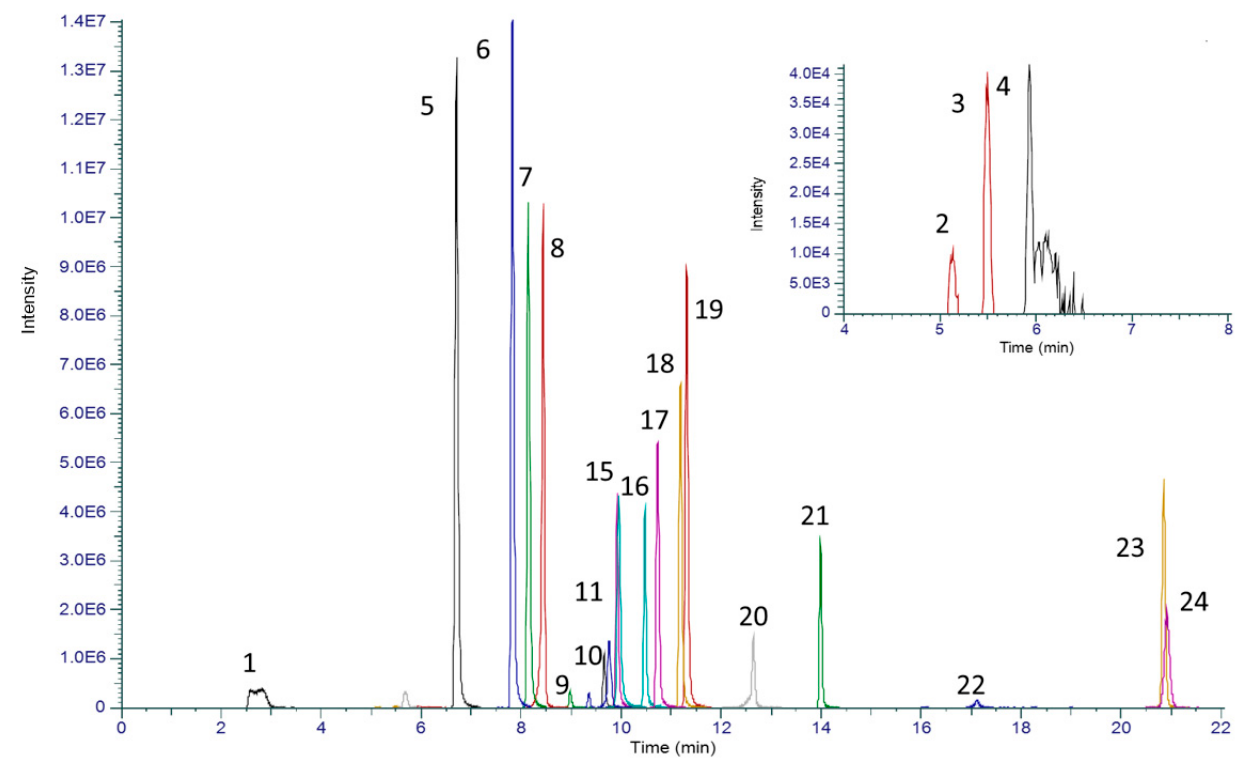
Figure 2. LC-MS chromatogram obtained for the standards (5 µg L − 1 ): 1—florfenicol amine, 2—